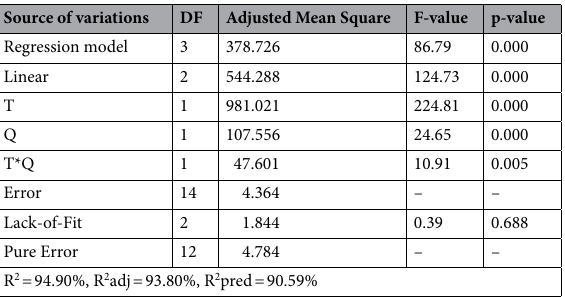
Table 2. Analysis of variance relevant to the residual enzyme activity.